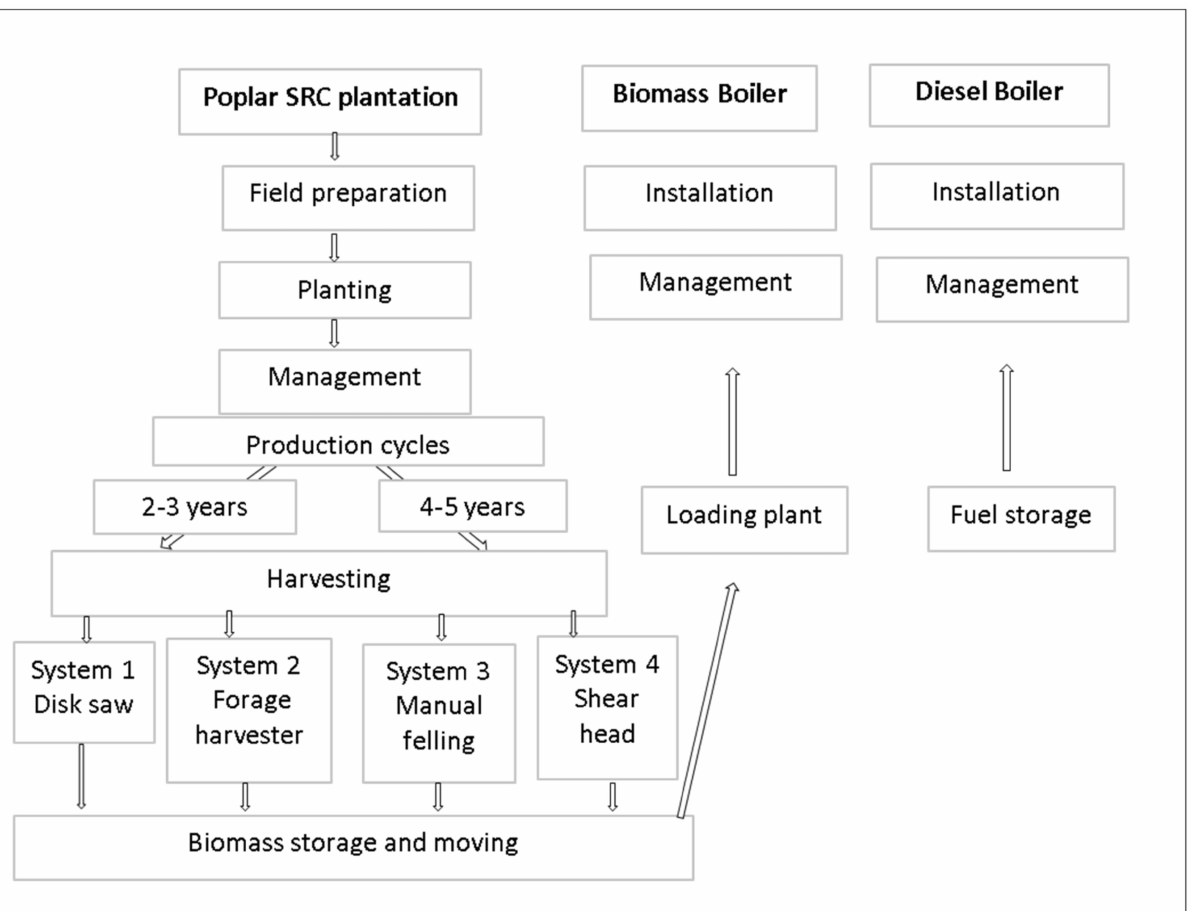
Scheme 1. Scheme of the poplar energy supply chain boundaries considered in the